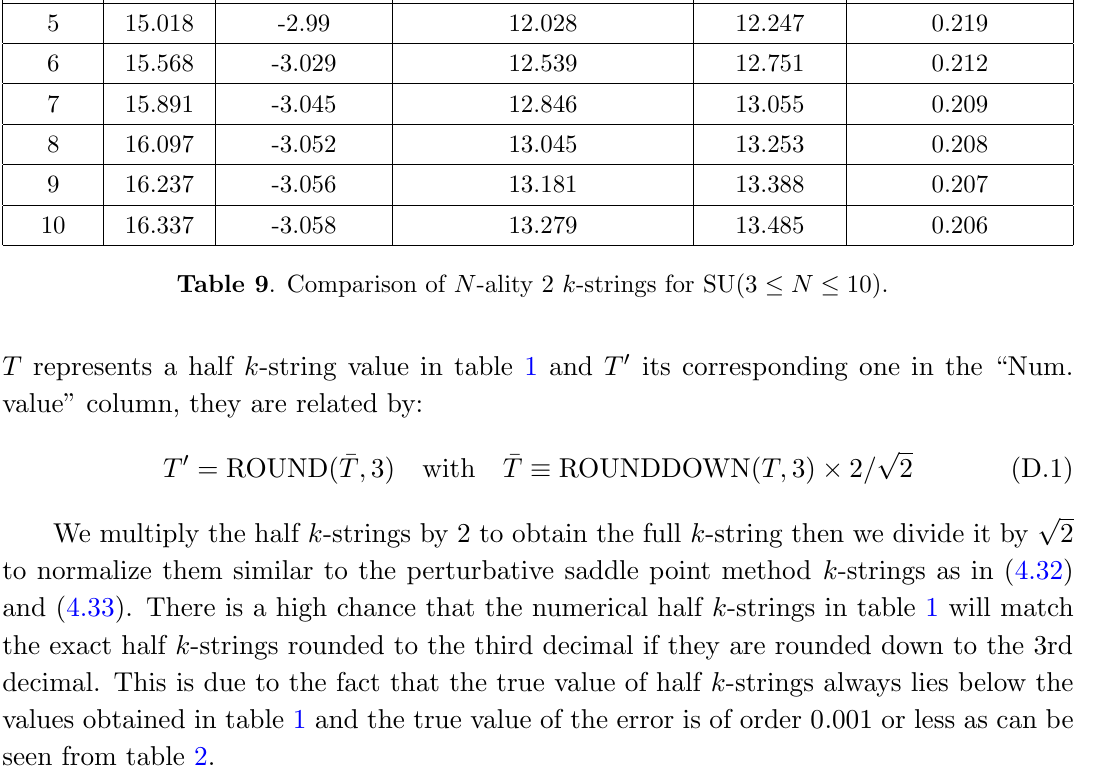
N 10). (cid:20) (cid:20)